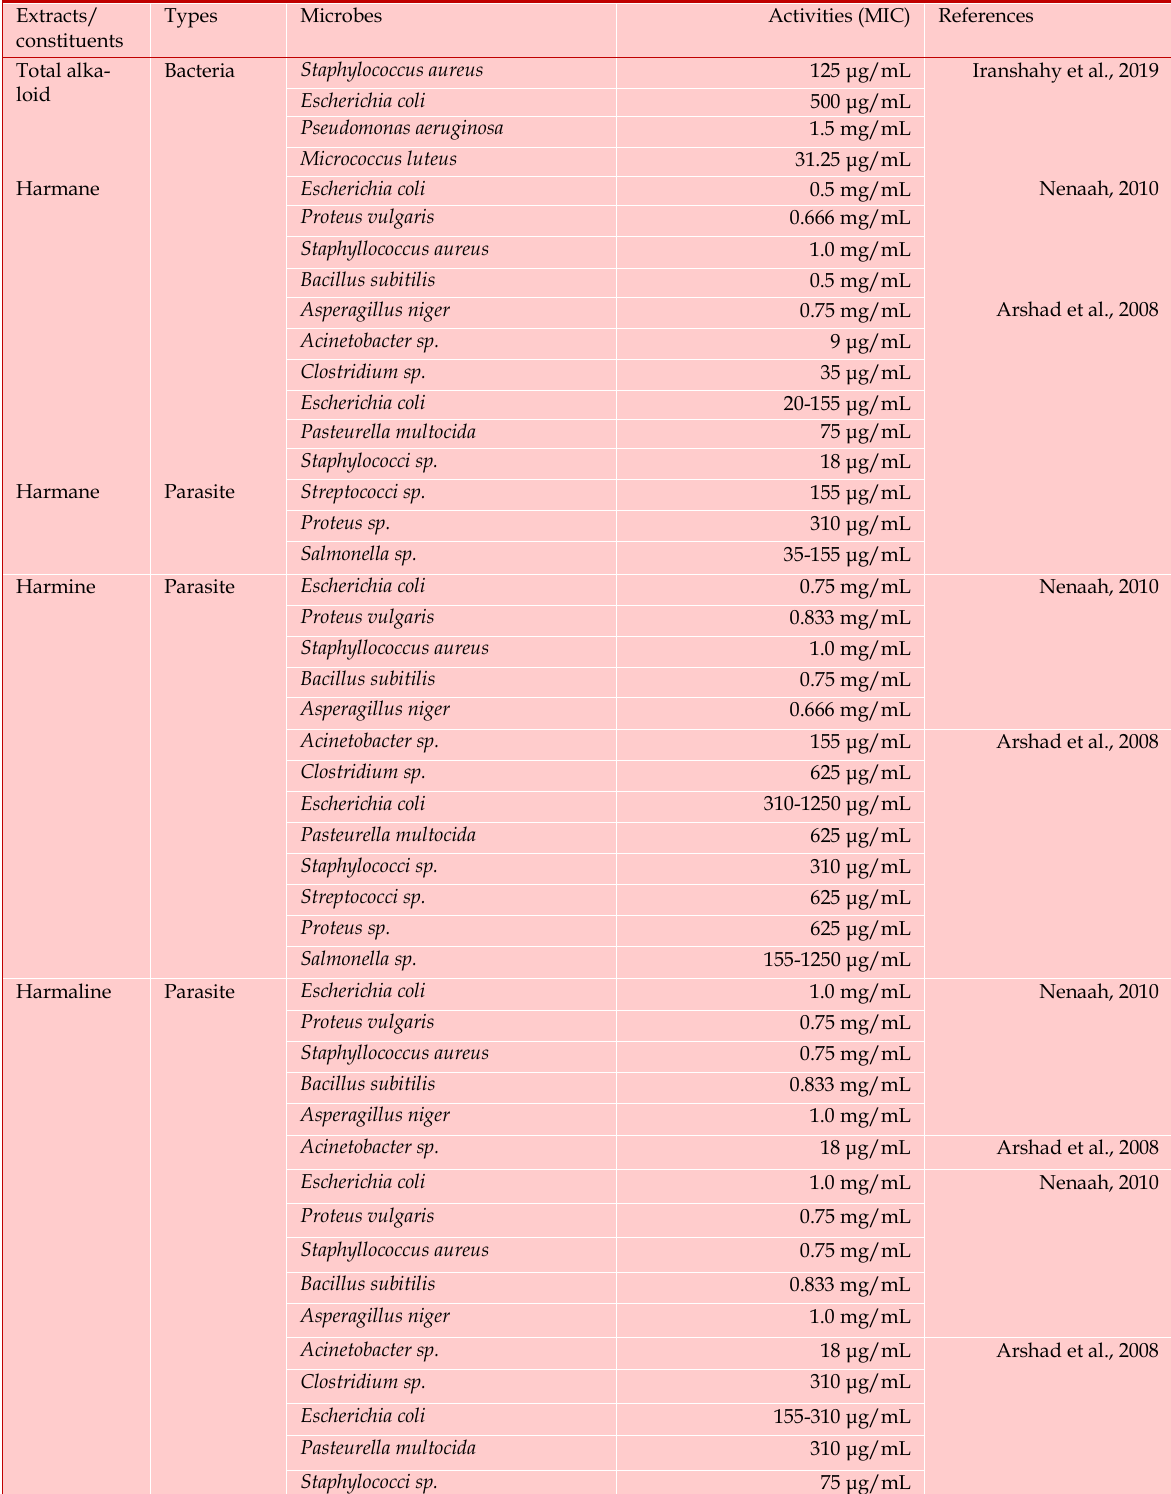
Antimicrobial activities of Peganum harmala